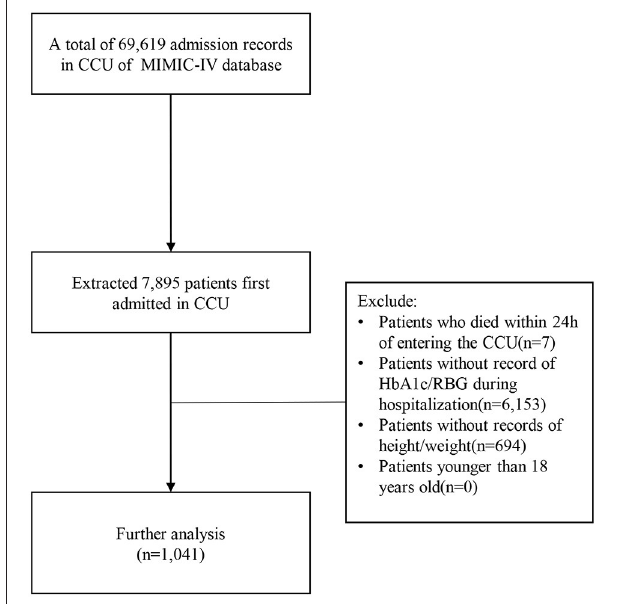
FIGURE 1 | Inclusion and exclusion flowchart of the